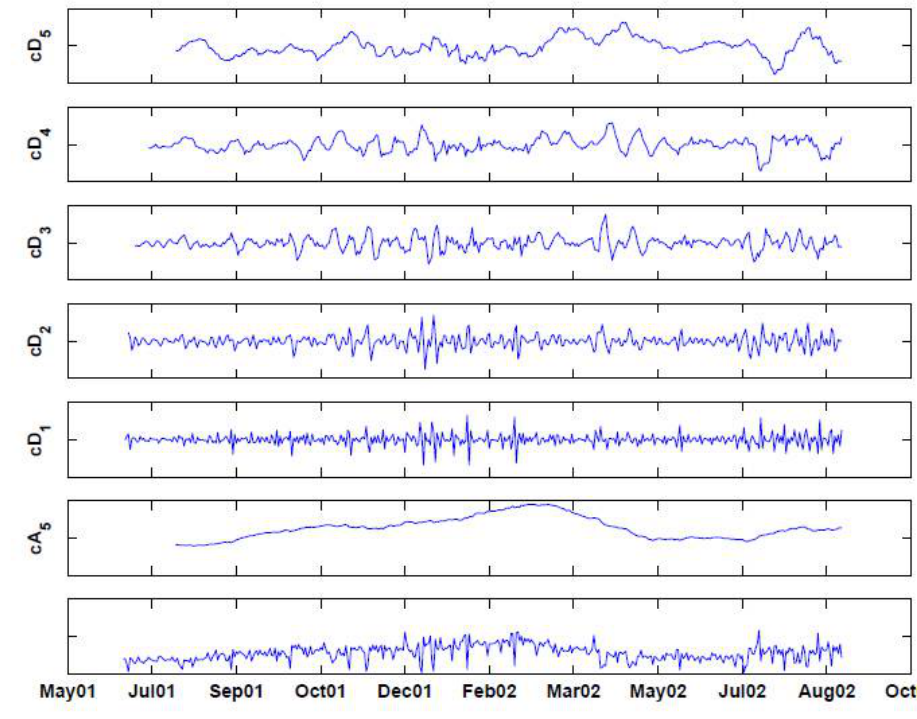
Figure 6. Decomposing the (deseasonalized) series of daily visits to military outpatient clinics into five levels using the “backward” Haar wavelet, without downsampling. The bottom panel displays the time-series. Above it are the fifth approximation ( cA − cD five levels of detail ( cD 5 1